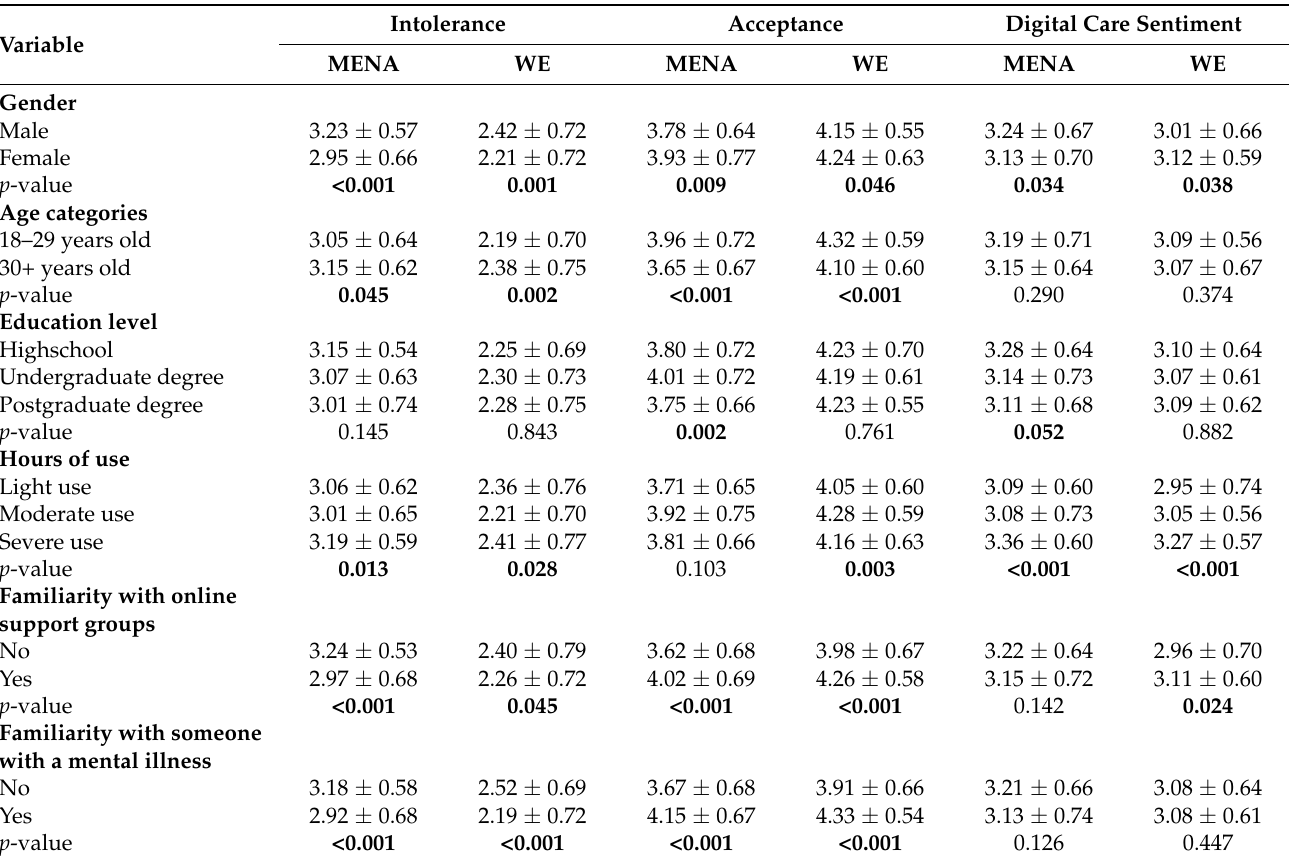
Table 5. Bivariate analysis of sociodemographic factors associated with each